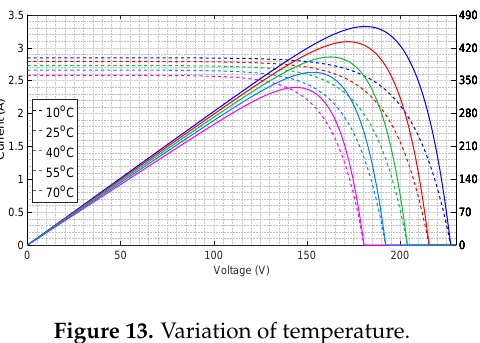
Figure 12. Variation of irradition.